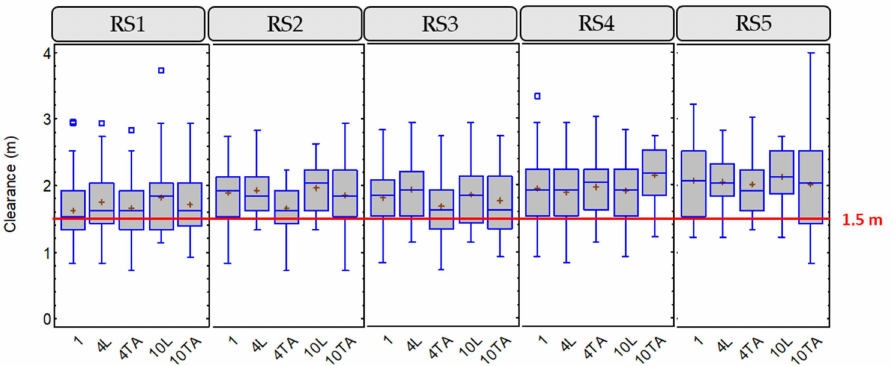
Figure 4. Box-and-whisker plot for lateral clearance, considering road segment and group configuration. RS1 and RS3 presented lower lateral clearance than other road segments, which correspond to the road segment with higher AADT (RS1) and the road segment with the red-colored shoulder (RS3). The road segment with higher lateral clearance was RS5, which is the one with higher width, considering both shoulder and